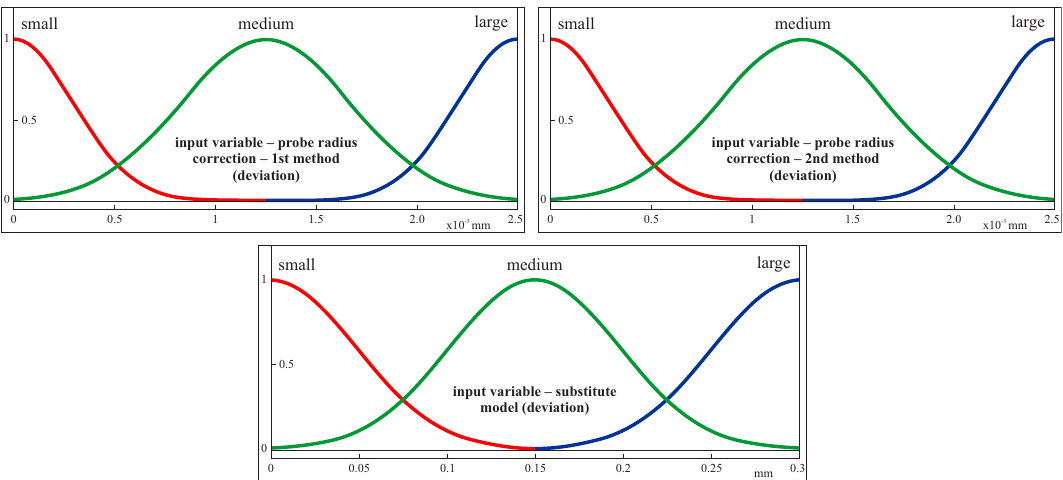
Figure 9. The membership functions for the input parameters in the case of both free-form surfaces and the second part of the expert